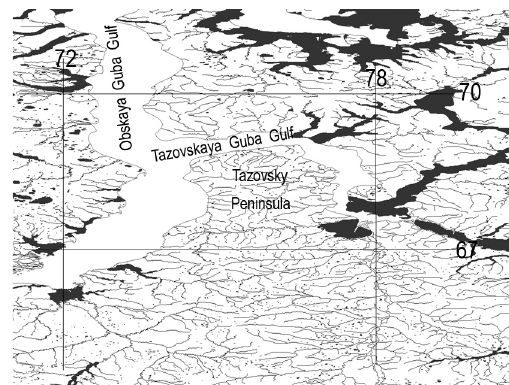
Fig. 4. Map of Srednesosvinskie and Verkhnevolinskie Uvaly Upland calving grounds.